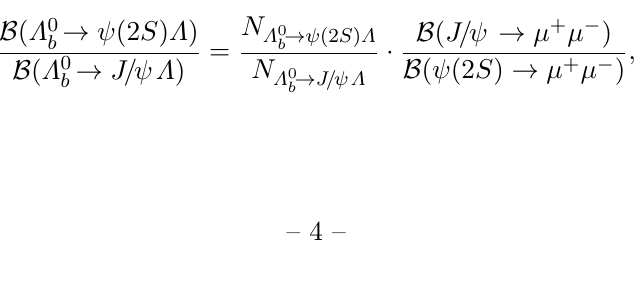
Figure 1 . Interpolated e(cid:14)ciency function for long-track candidates for (a) (cid:3) 0 (b) (cid:3) 0 ! J= (cid:3) and for downstream-track candidates for (c) (cid:3) 0 b candidates. The distribution of the candidates on data is shown with black dots (each dot refers to one candidate). Statistical (cid:13)uctuations of the simulated sample are contributing to the e(cid:14)ciency function at the phase-space boundaries, where data candidates are not